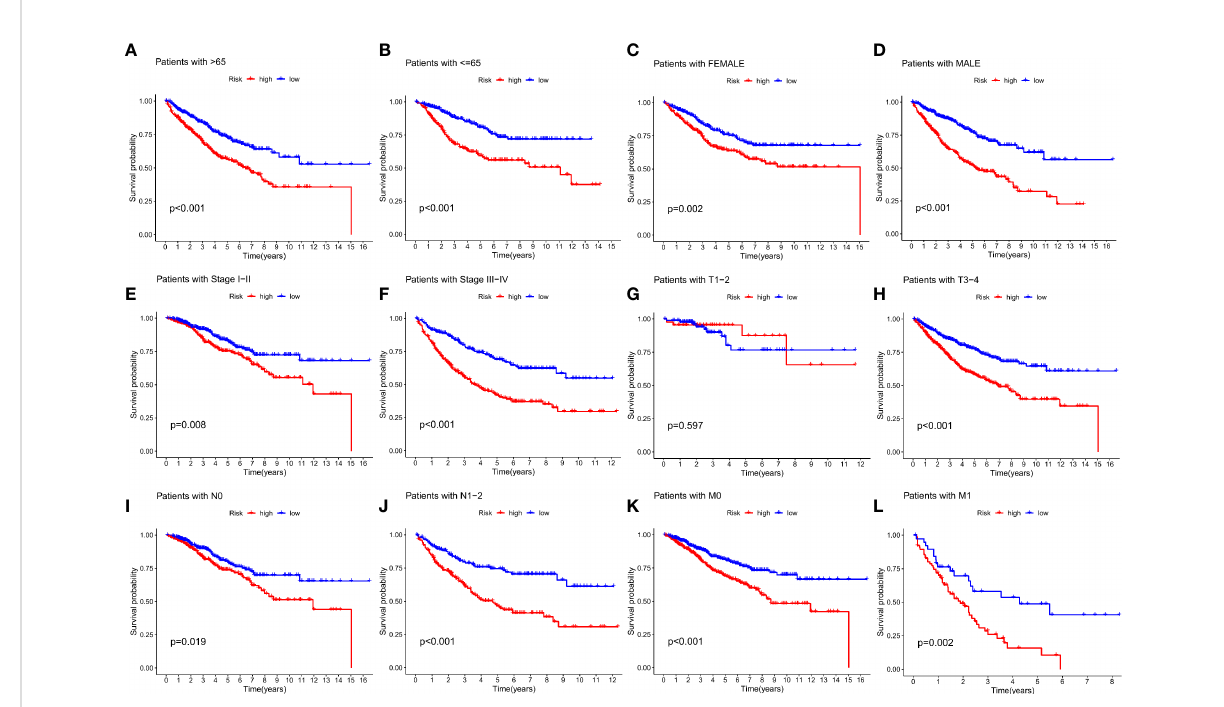
FIGURE 5 Relationship between IMRG risk scores and clinicopathologic characteristic subtypes in COAD patients. (A, B) age (< = 65, > 65); (C, D) gender (female, male); (E, F) stage (stageI-II, stage III-IV); (G, H) T (T1-2, T3-4); (I, J) N (N0, N1-2); (K, L) M (M0,